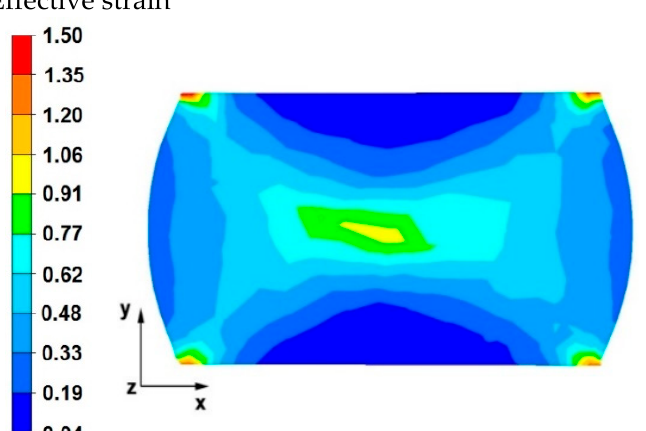
Figure 14. Distribution of the effective strain values on the surface of the cross-section of the sample with modeled discontinuity after deformation with 35% reduction.